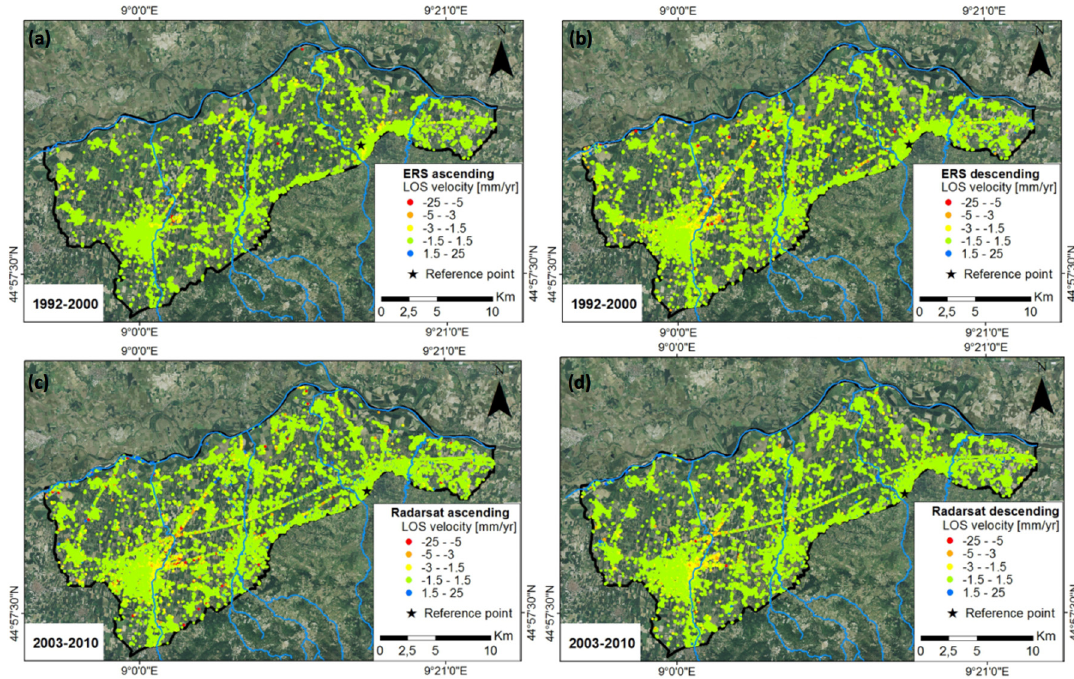
Table 1. Details on the SAR datasets, their processing, and results.